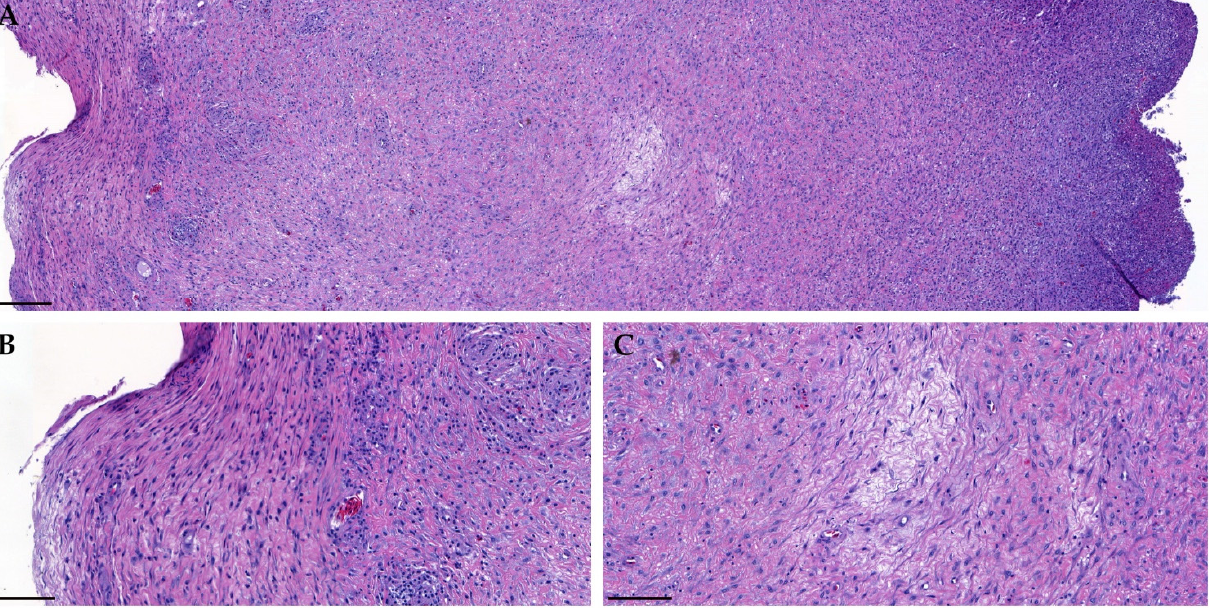
Figure 4. Histological examination of the mass (hematoxylin and eosin stain). ( A ) Low power ( × 7) of the mass. Inner border (right side) of the mass demonstrates massive heterophile infiltration (scale bar = 200 µ m). ( B,C ) High power ( × 30) of the mass. The neoplasm was poorly demarcated, moderately to densely cellular, infiltrative, and composed of neoplastic spindle cells that formed loose interlacing streams and bundles within a mild fibrovascular stroma (scale bar = 100 µ m).